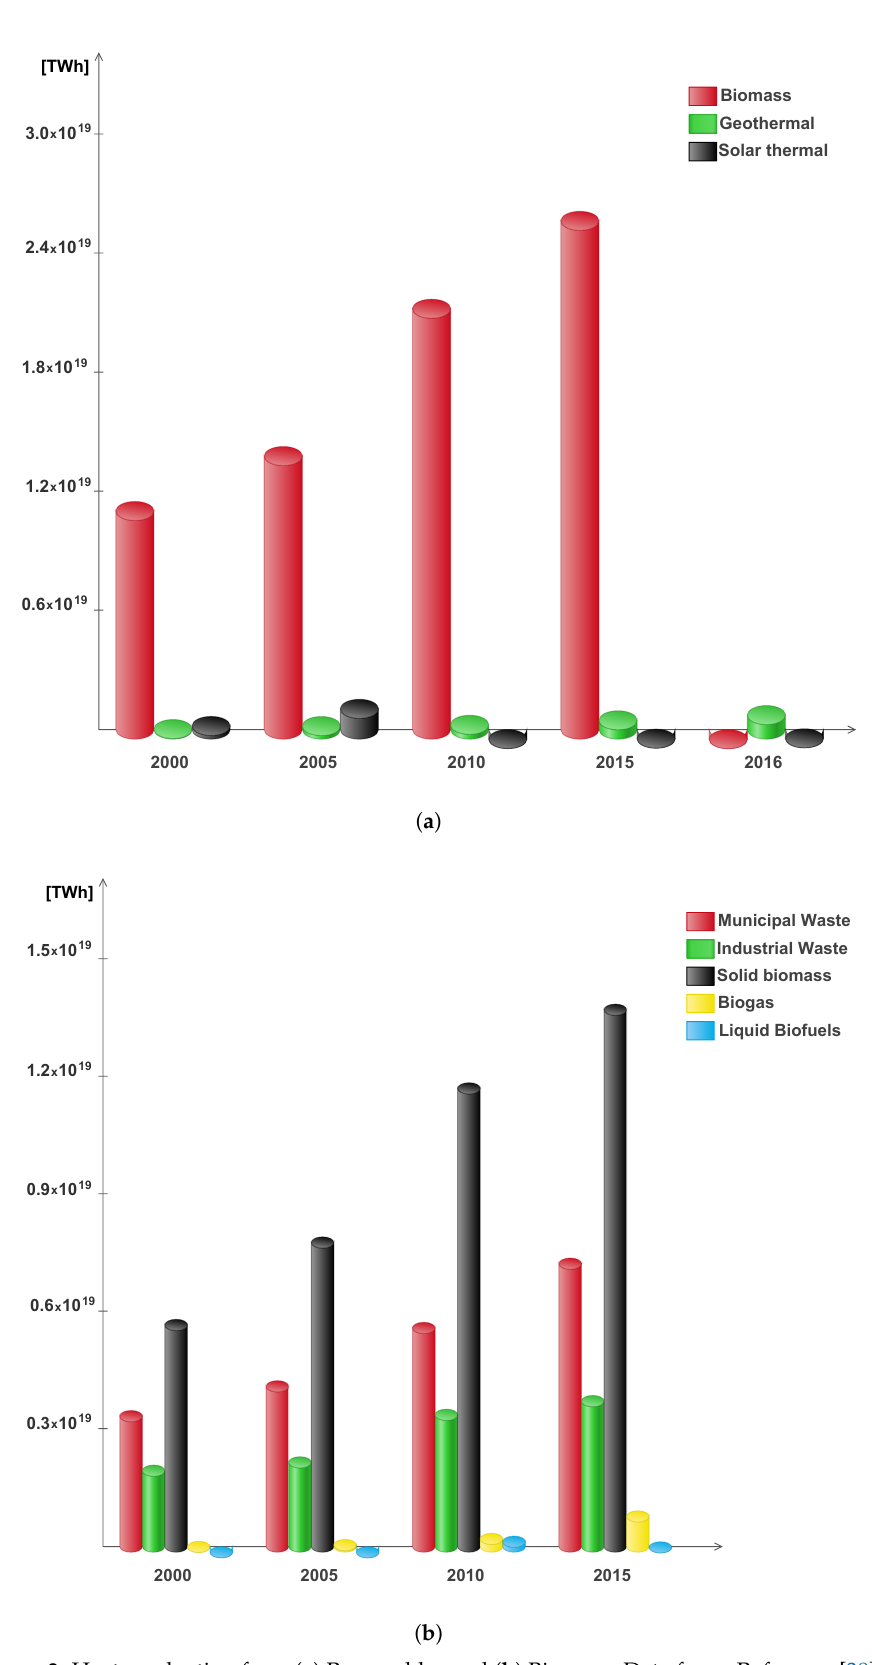
Figure 3. Heat production from ( a ) Renewables and ( b ) Biomass. Data from: Reference